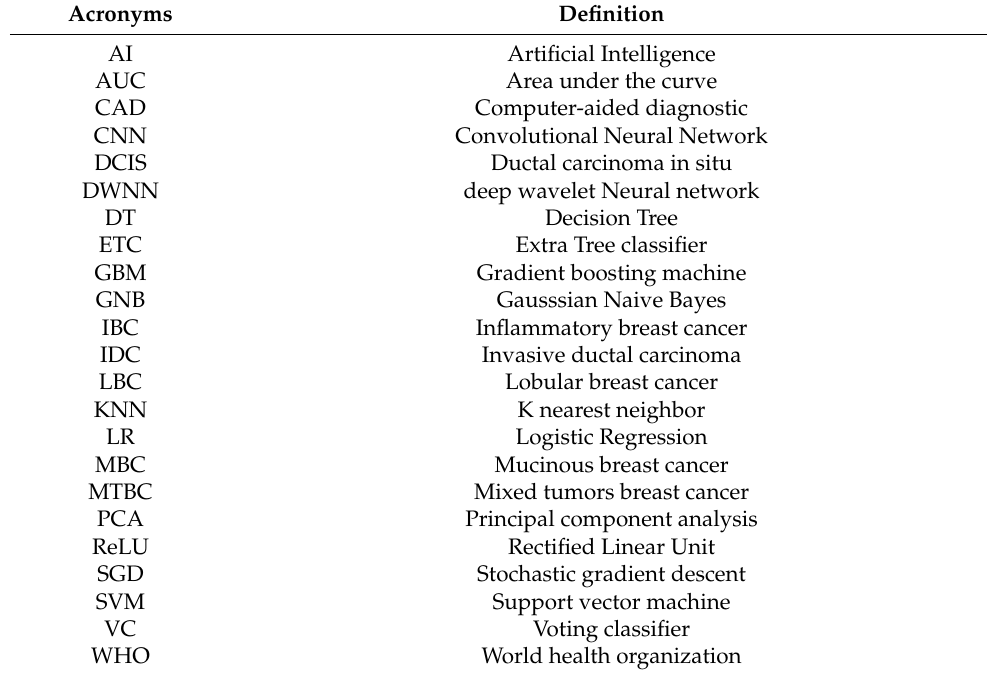
Table 8. The acronyms used in this